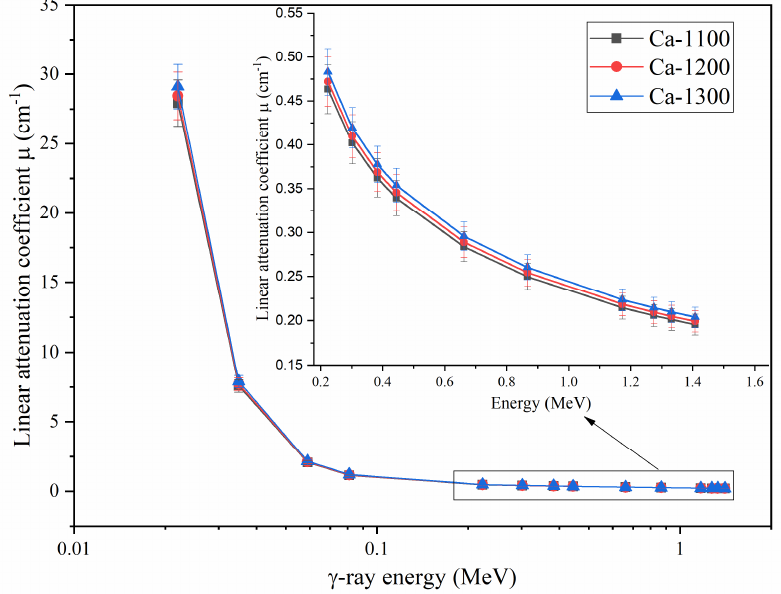
Figure 3. The µ value variations versus the incident γ-photon energies.